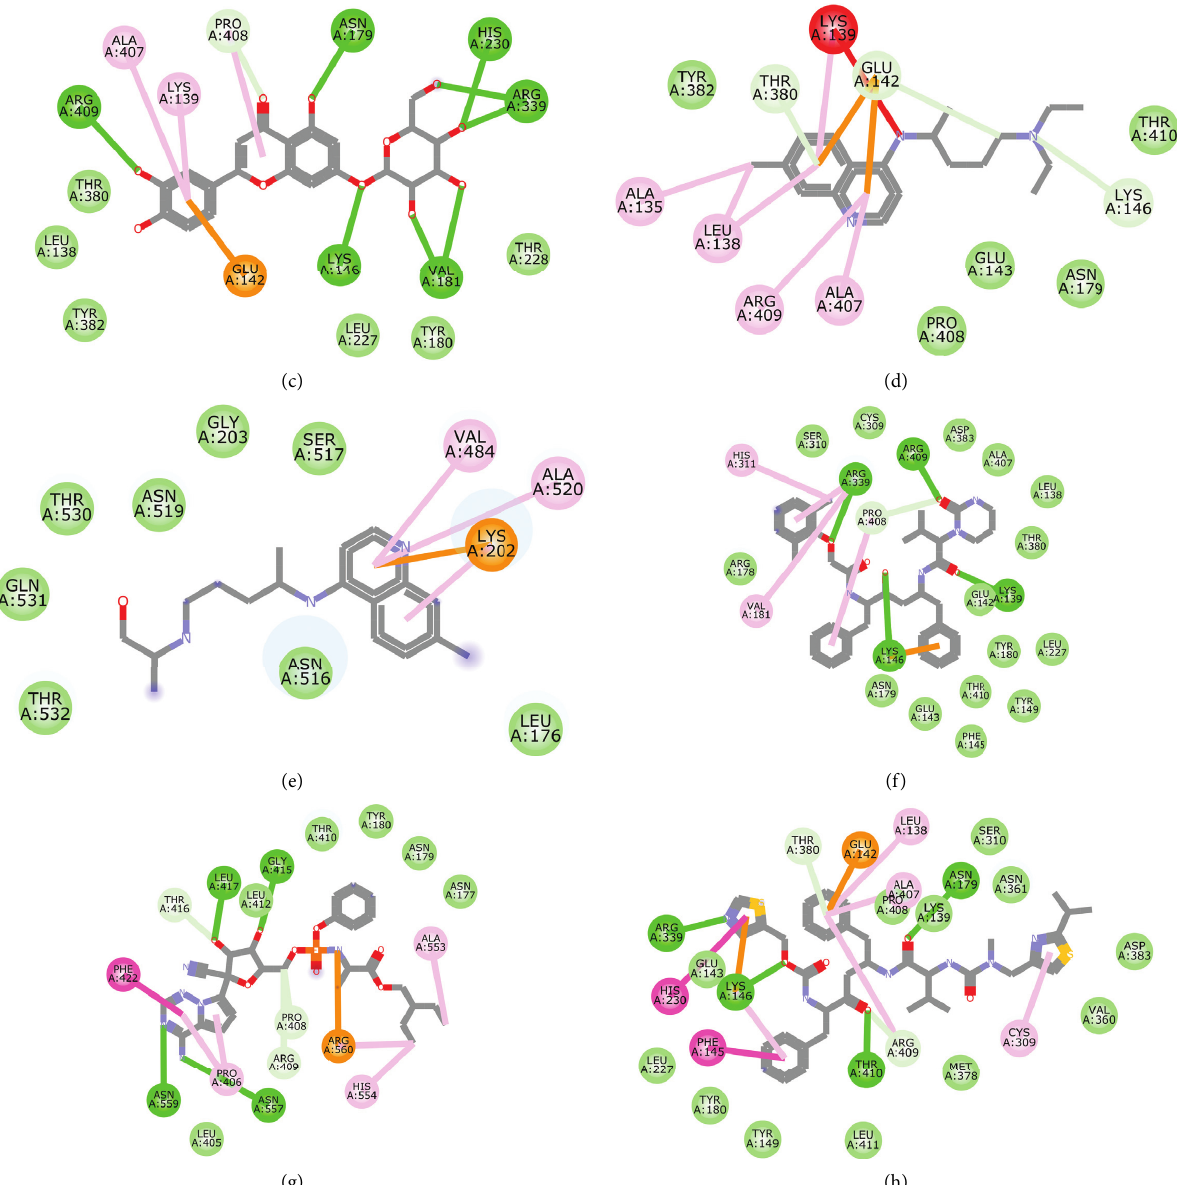
Figure 5: 2D representation of (a) 3-galloylcatechin, (b) proanthocyanidin B1, (c) luteolin 7-galactoside, (d) chloroquine, (e) hydrox- ychloroquine, (f) lopinavir, (g) remdesivir, and (h) ritonavir in the binding pocket of helicase. Hydrogen, carbon-hydrogen, and unfavourable and π bonds are depicted as green, light blue, red, and any other coloured (purple, magenta, orange, turquoise blue, pink, and yellow) lines, while Van der Waal interactions appear as light green